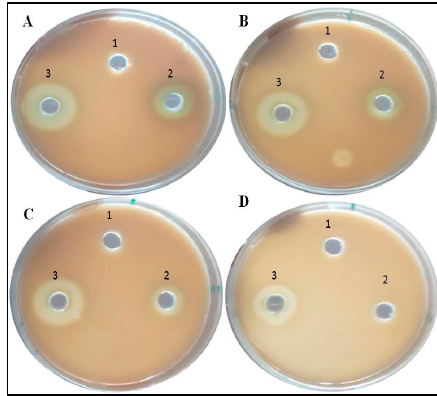
Figure 7. Bar graphs of clinical isolates of P. aeruginosa representing pyocyanin production (µg/mL) at three different concentrations (100, 200, 300 µg/mL) of BM-ZnO NPs along with control as untreated. * represents significance when p ≤ 0.05/mL; Error bars represent standard deviation.